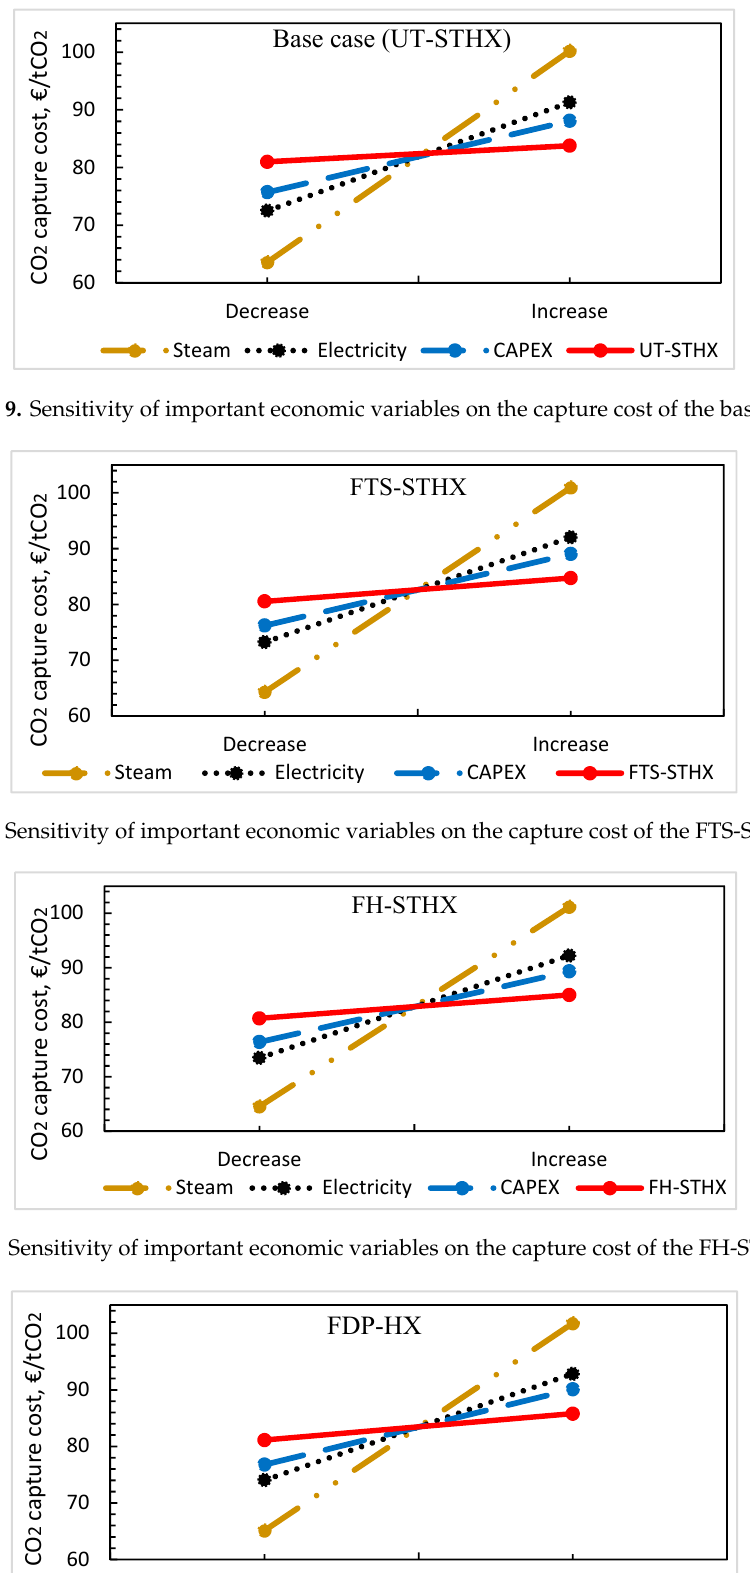
Figure 13. Sensitivity of important economic variables on the capture cost of the W-PHE case. Figure 14. Sensitivity of important economic variables on the capture cost of the G-PHE case. 3.9. Discussion of Technical Considerations The shell and tube heat exchangers are the most common [18–20], and the most technically robust [18] heat exchangers, and they can be applied in all processes. The G-PHE is technically good for low-pressure heat exchanges between liquid streams [19]. The STHXs have well-established design codes, standards, and specifications, which are not available for the PHEs [19,20]. Thus, design uncertainties will be higher for the PHEs [78]. The tubular exchangers can withstand higher pressures, higher pressure differences, and lesser pressure-drop compared to the PHEs. The tubular heat exchangers also have a higher temperature and higher temperature difference tolerances [18,20]. That implies the tubular exchangers have better thermal strength and stability. However, the plate heat exchangers by far have a higher overall heat transfer coefficient (U-values) [19]. In addition to the higher U-values of the PHEs, they have an order of magnitude more surface area per unit volume